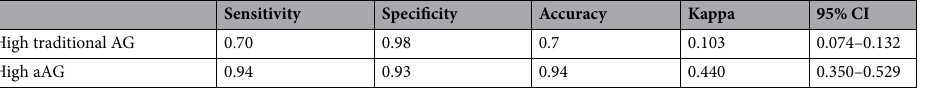
Table 1. Sensitivity, specificity, accuracy and agreement of high AG criteria between the full AG equation and the other 2 equations. aAG albumin-adjusted